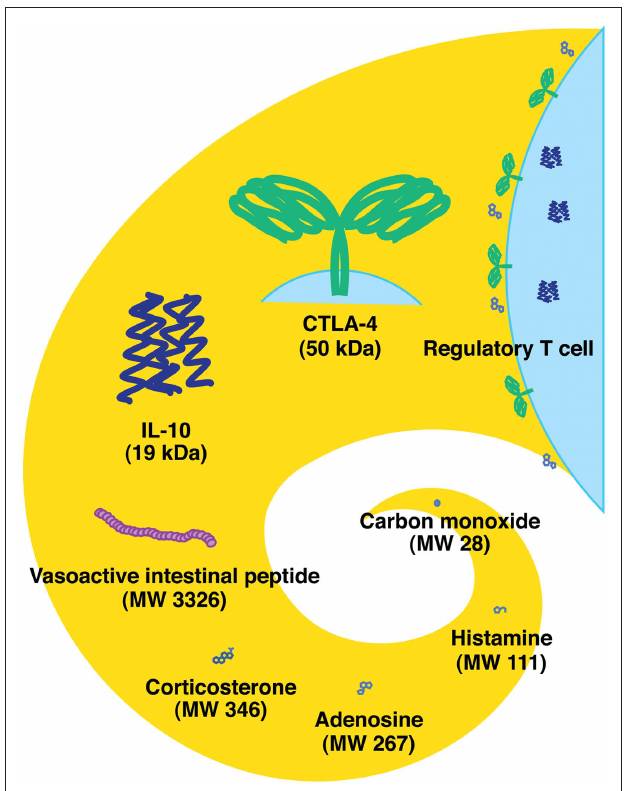
FIgure 1 | endogenous immunoregulatory mechanisms from tiny molecule to cells. Molecular weight of CTLA-4 represents the approximate size of a homodimer. Tregs express CTLA-4 and produce IL-10 and adenosine.